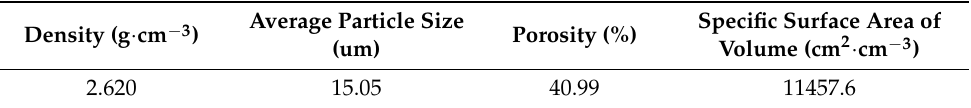
Table 2. Physical parameters of used